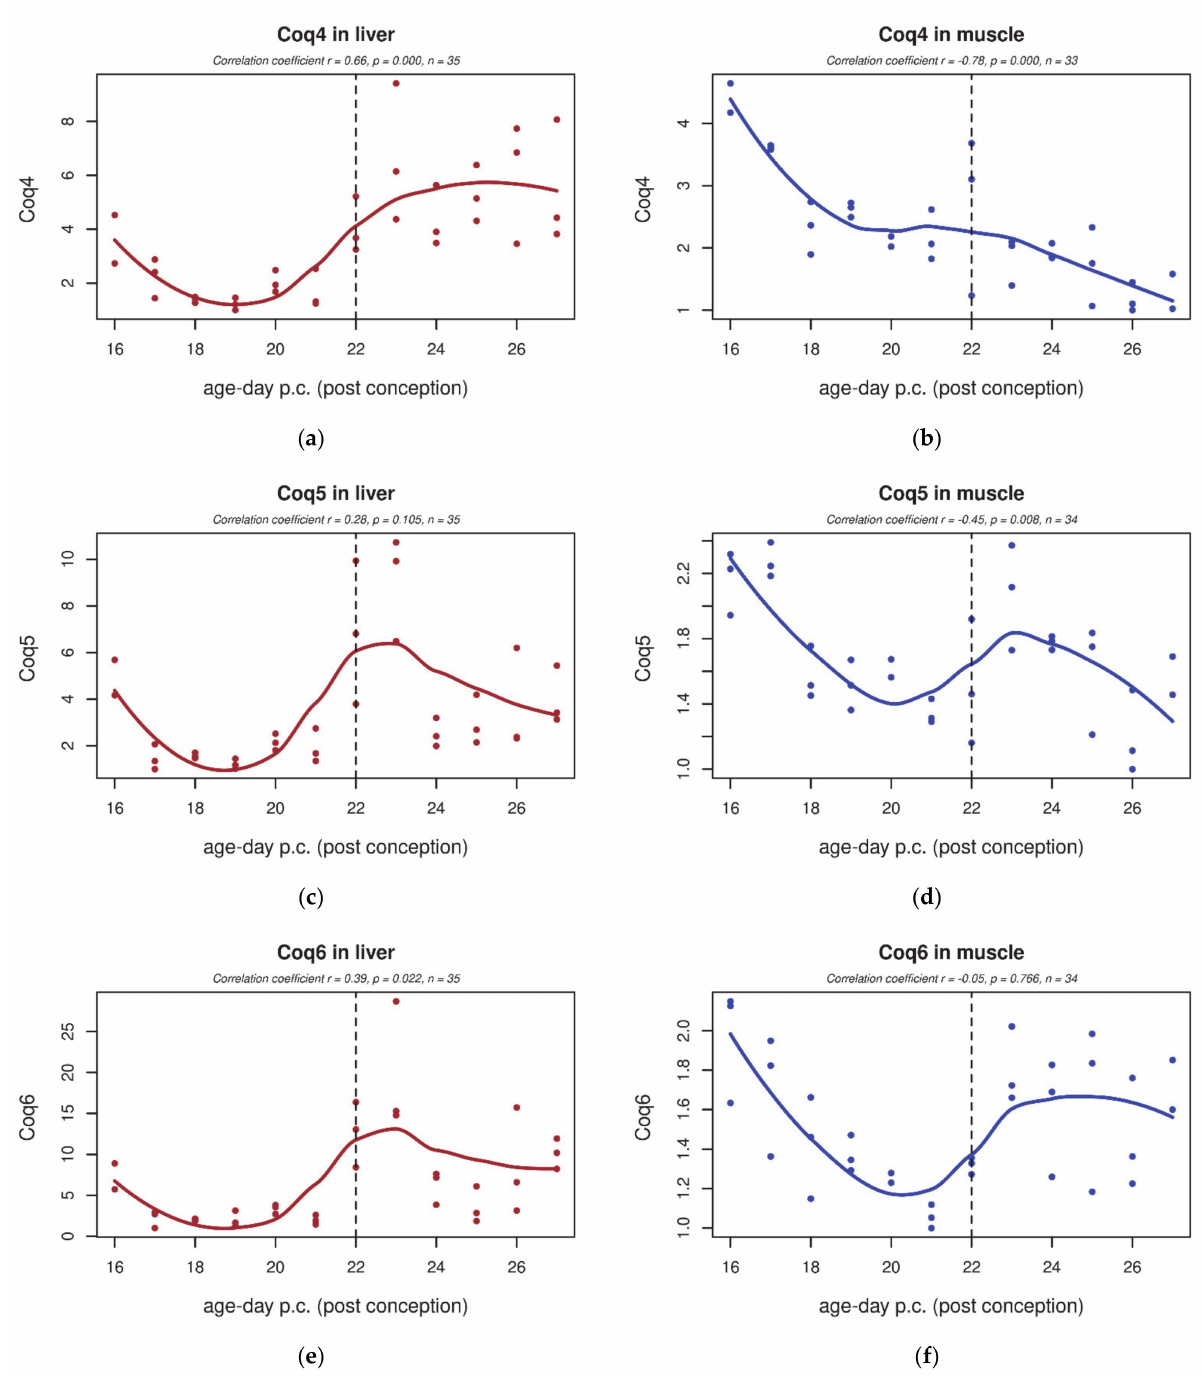
Figure 8. Coq4 , Coq5 and Coq6 expression in rat tissues during early development. ( a ) In the rat liver, we detected that the Coq4 transcript is significantly increased after birth. ( c , e ) Coq5 and Coq6 showed a transiently (but not significantly) increased expression around days F22 and P1. ( b ) In skeletal muscle, Coq4 showed a decreasing tendency throughout the whole studied period. ( d , f ) Genes Coq5 and Coq6 did not show any significant trend during perinatal development. The dashed line indicates the last foetal